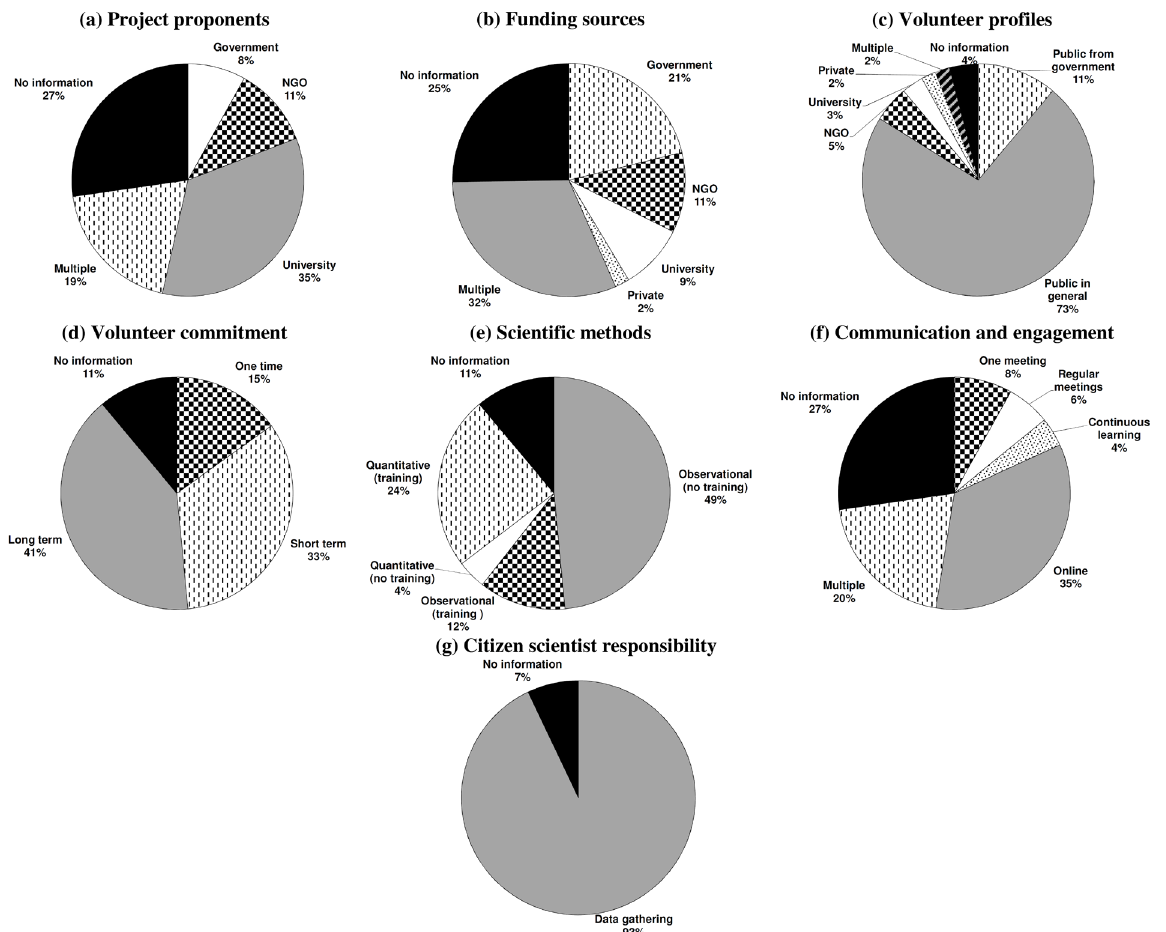
Figure 7 - Characterization of the 126 analyzed citizen science projects regarding: project proponents ( a ), funding sources ( b ), volunteers profiles ( c ), volunteer commitment ( d ), scientific methods ( e ), communication and engagement ( f ) and citizen scientist responsibility ( g ). “No information” means the information was never provided or, if provided, was